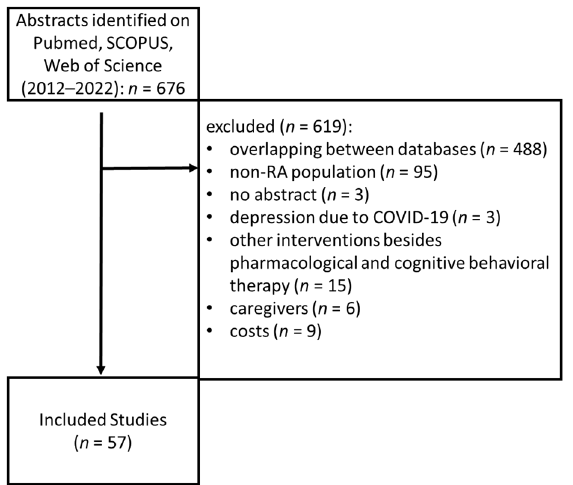
Figure 1. Study selection for inclusion.